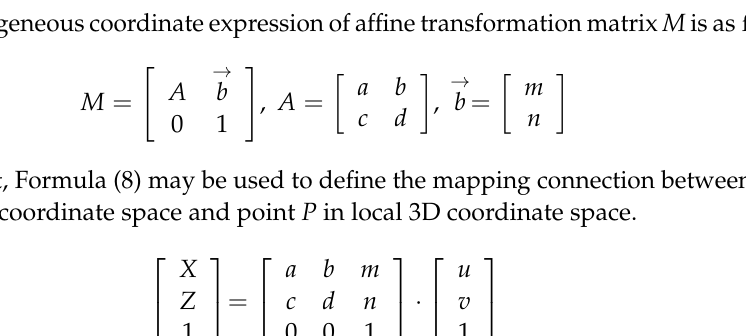
Figure 4. Schematic diagram of the process of converting 2D texture coordinates to 3D model coordinates. ( a ) 3D coordinate system. ( b ) Texture coordinate system. ( c ) Local 3D coordinate system.